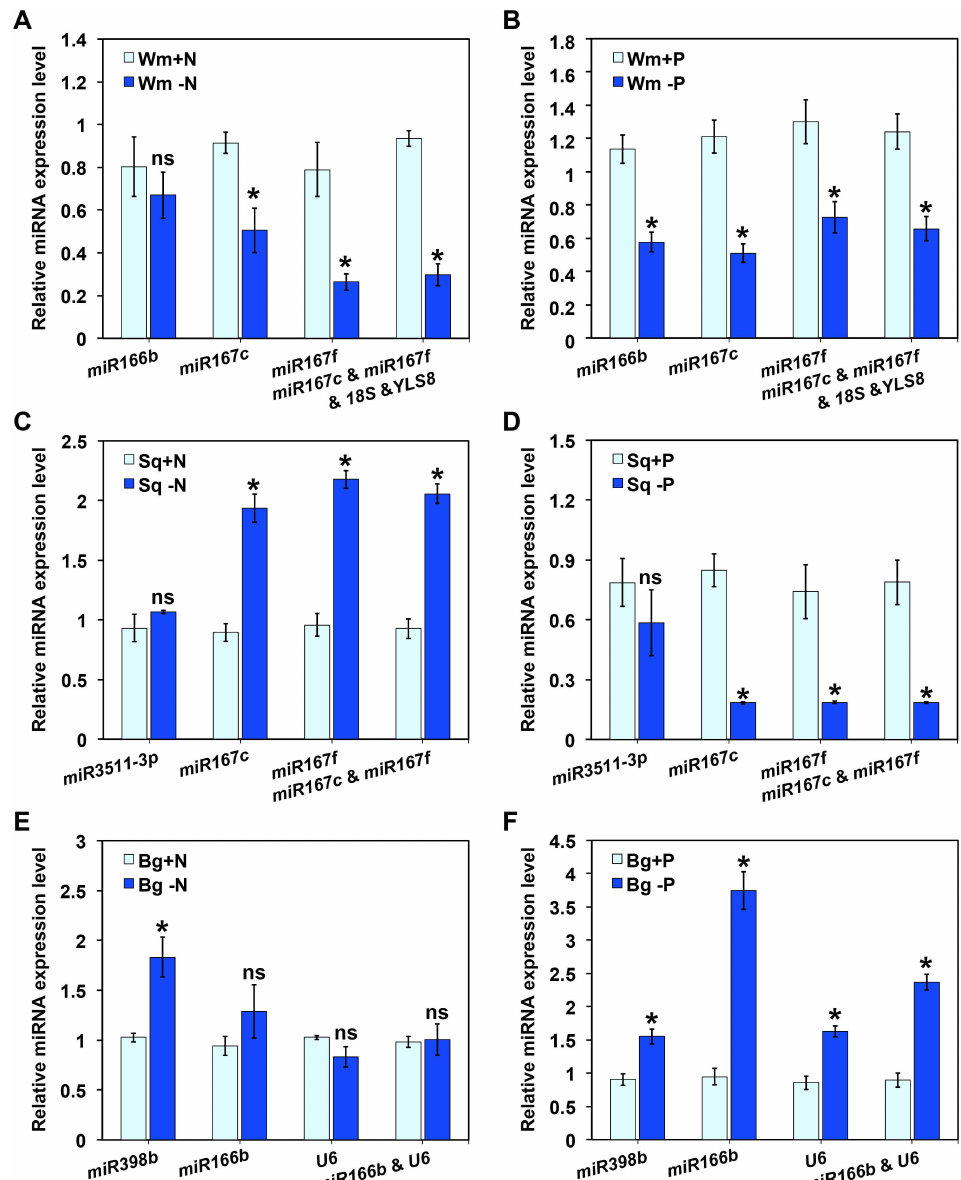
Fig 5. Relative expression of miR85 in grafted watermelon under nutrient stresses. miR85 expression levels in (A) and (B) leaves of self-grafted scions, (C) and (D) roots of non-graftedsquash, (E) and (F) roots of non-graftedbottle gourd under N or P stresses were normalized by the least stable, single most stable and best pair of reference genes (range from left to right). For the pair of best reference genes and multiple reference genes, their geometric mean was calculated and used for normalization. The relative expression levels are exhibitedas the mean ± SD, which was calculatedfrom three biologicalreplicates. Asterisk ( * ) indicates significant difference and ns indicatesno significant difference between +N and –N, +P and -P ( P < 0.05, one-way ANOVA and then Tukey’s test for multiple